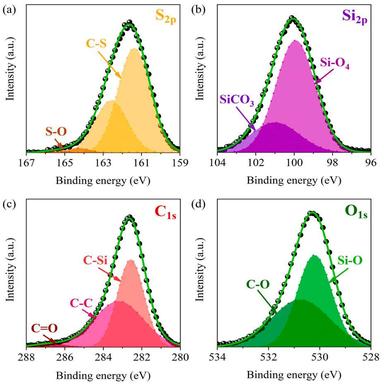
High-resolution XPS spectra of the S-SiOC powder, displaying the (a) S2p, (b) Si2p, (c) C1s, and (d) O1s orbitals.